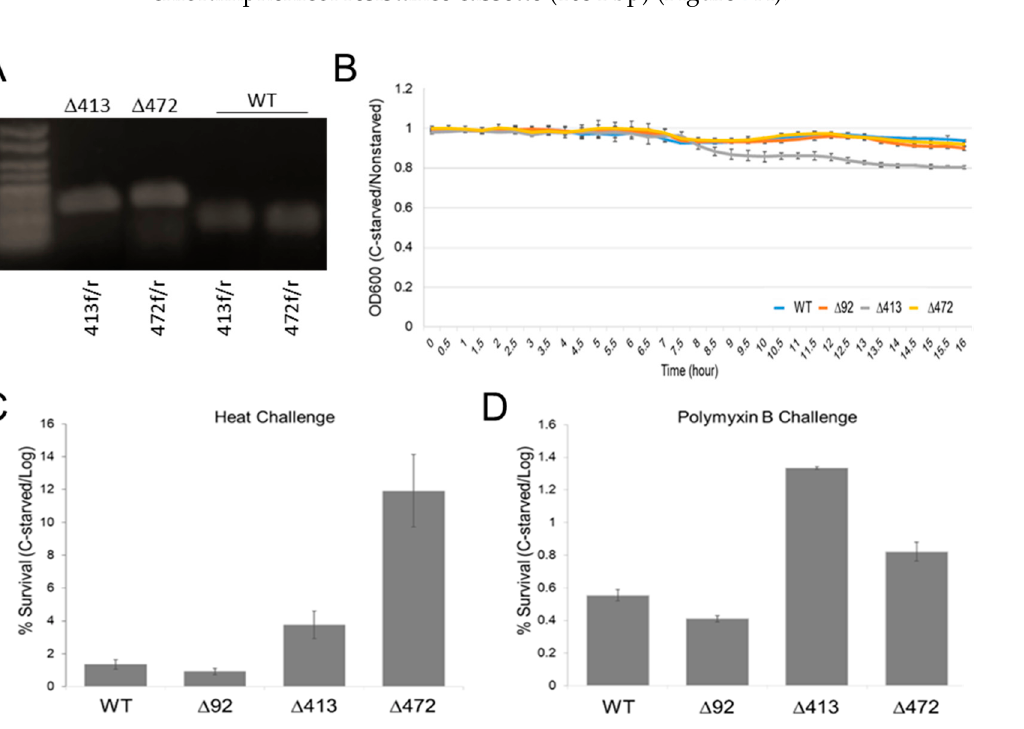
Figure 7. Effects of silencing sRNA4130247 and sRNA4720054. ( A ) PCR confirmation of sRNA genomic replacement with chloramphenicol resistance cassette. Arrowheads indicate 1000 and 200 bp ladder bands. Lane 1, lkb ladder. Lanes 2–3, mutant colonies (harboring ~1000 bp insertions at indicated loci). Lanes 4–5, wild type sRNA amplicons (<200 bp). Primer sets are indicated below image. ( B ) Growth of deletion mutants and wild type Salmonella in normal and low-carbon media. OD600 ratio (C-starved/nonstarved) determined every 30 min for 16 h. ( C ) Ratio of C-starved/nonstarved cell survival of log phase deletion mutants and wild type Salmonella subjected to 55 ◦ C for 30 min. ( D ) Ratio of C-starved/nonstarved cell survival of deletion mutants and wild type Salmonella during Polymyxin B exposure. Error bars in B-D indicate SD (n = 3). Survivals were normalized to wild type (WT). ∆ 413, sRNA4130247 deletion mutant; ∆ 472, sRNA4720054 deletion mutant; ∆ 92, STnc1200 sRNA deletion